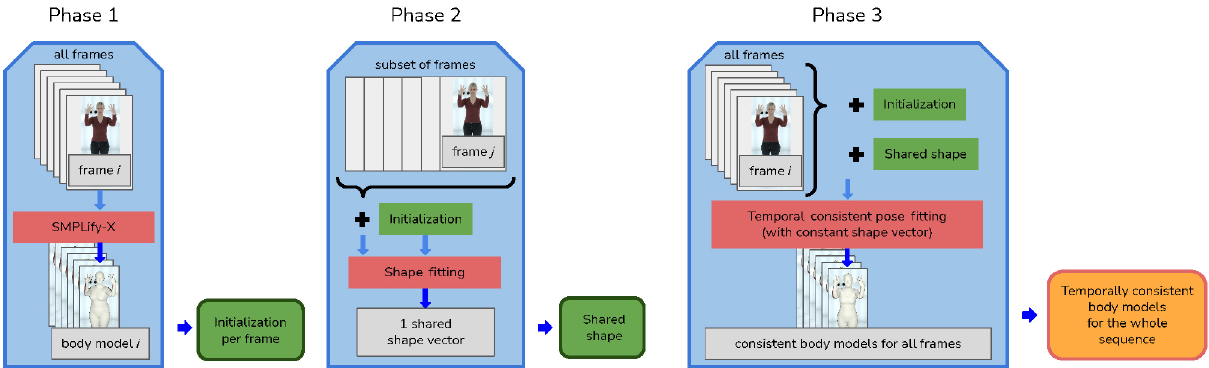
Fig. 1 Method overview with three phases. Interim results: green blocks. Optimization frameworks: red blocks. Optimization uses a reprojection error to OpenPose keypoints and assorted priors, and consists of 5 stages with different weights. Phase 1 optimizes on individual frames; phases 2 and 3 optimize over sets of